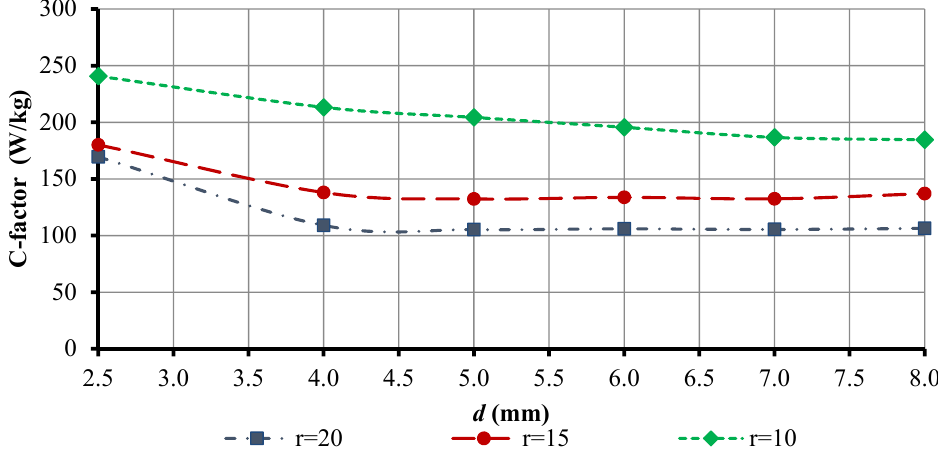
Figure 16. Effects of fitting diameters and constrictions on BGD flow and power characteristics at different conical insert radii.